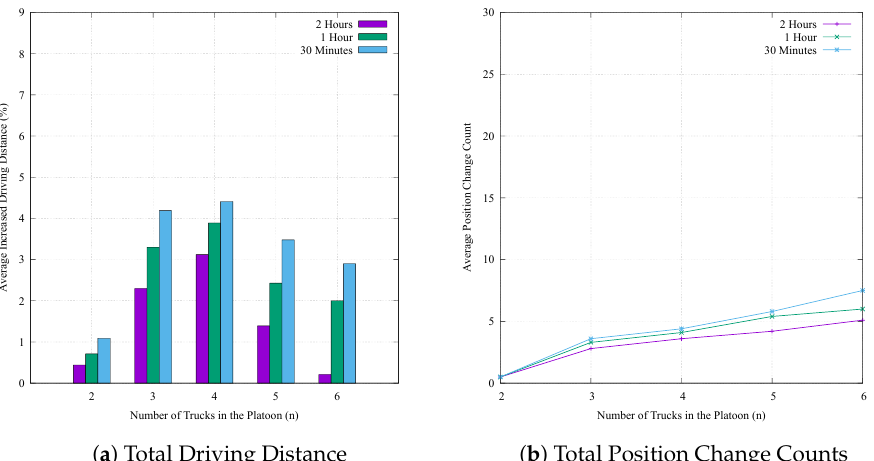
Figure 5. Performance of STS with an unequal initial fuel ( δ